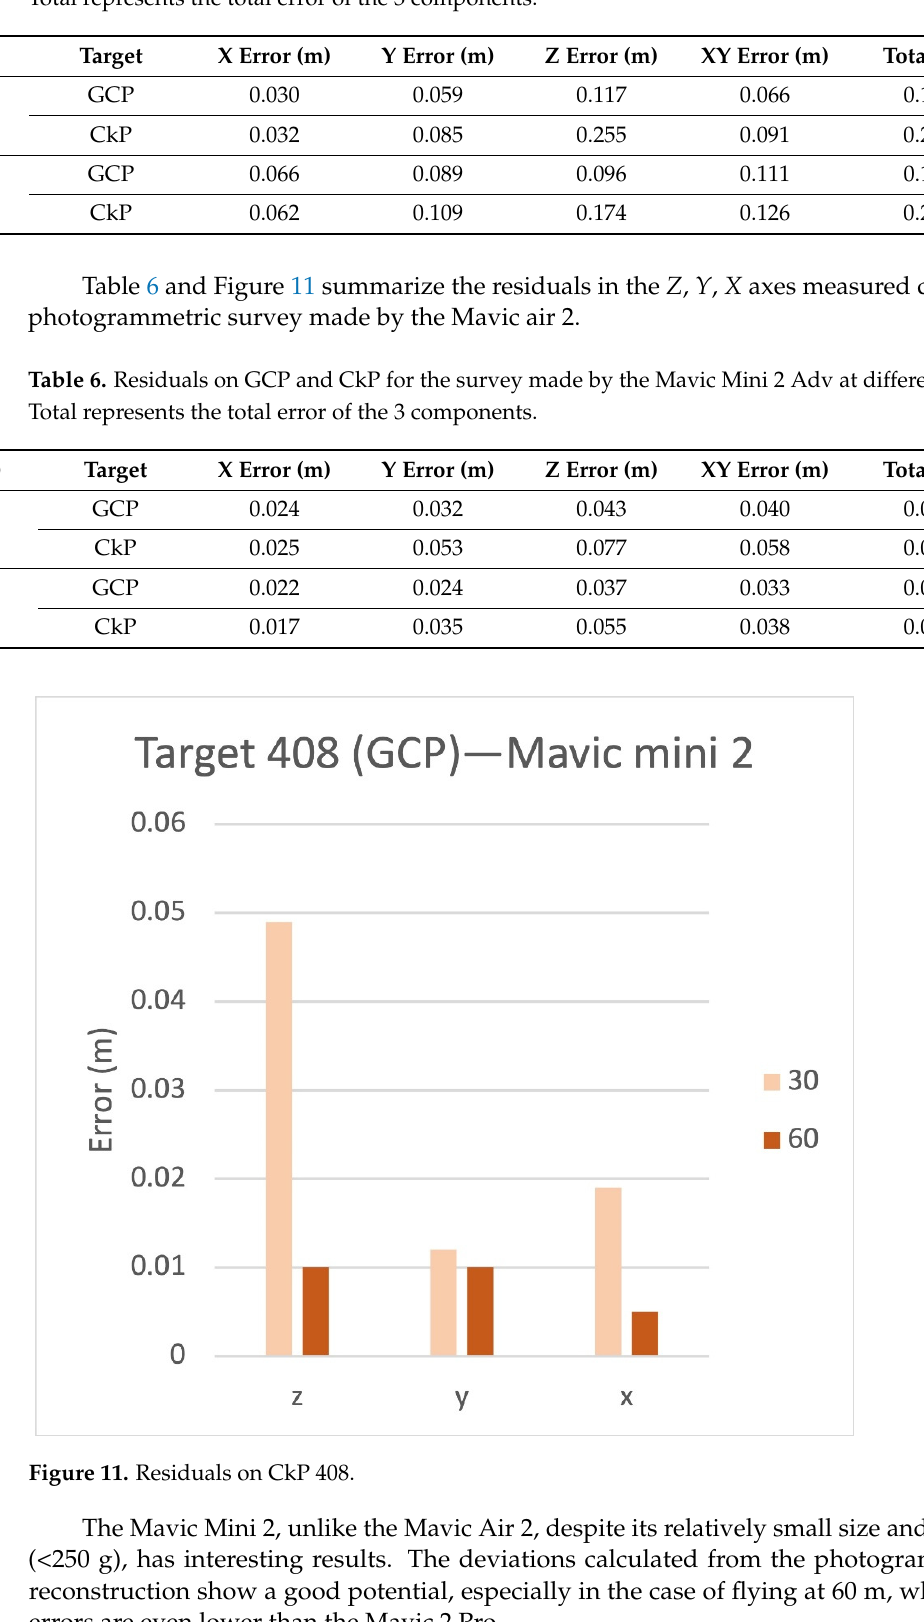
Table 7. Residuals for 60 m AGL flights for all the UAS models. Total represents the total error of the 3 components.